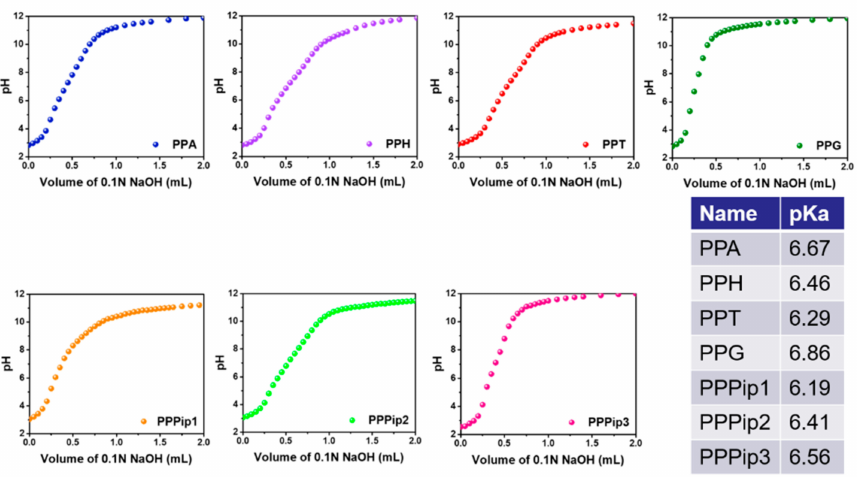
Figure 3. Acid–base titration curve of PPA variants. Inset table is for the corresponding pKa of PPA